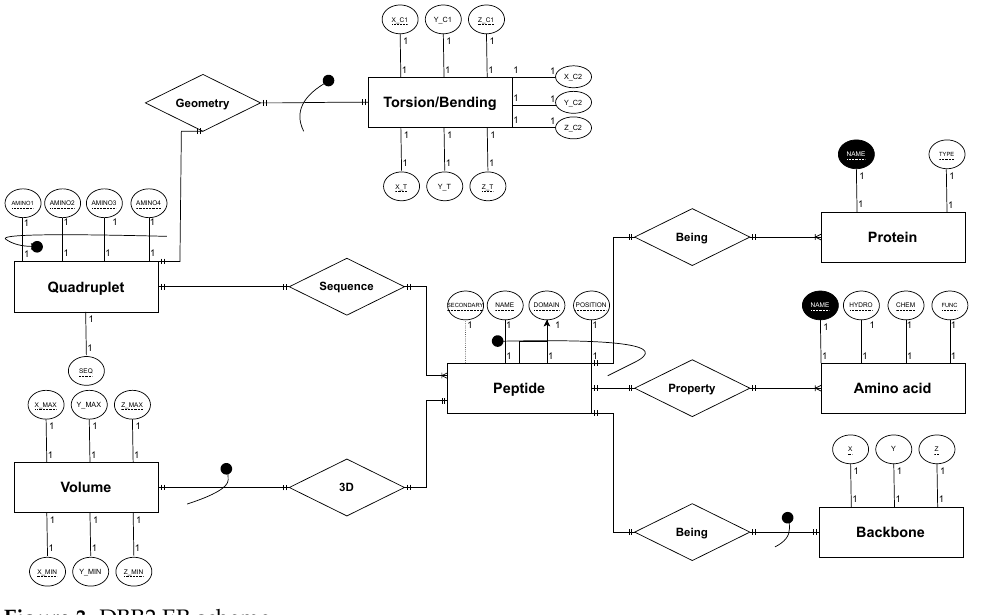
Figure 3. DBR2 ER